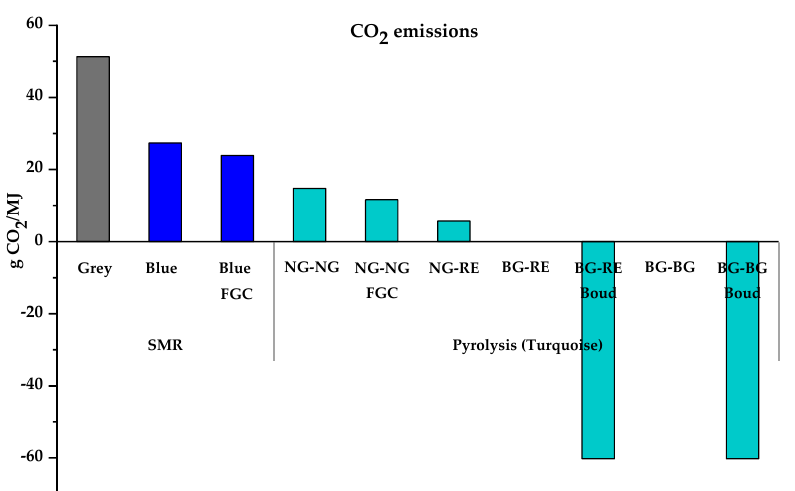
Figure 7. The CO 2 emission from grey, blue, and turquoise hydrogen production.